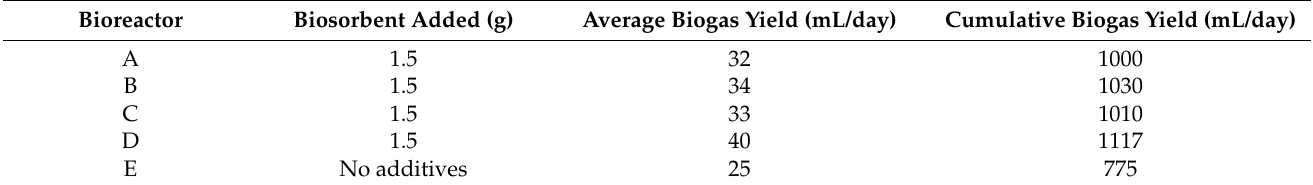
Table 4. Average and cumulative biogas yield for HRT 30